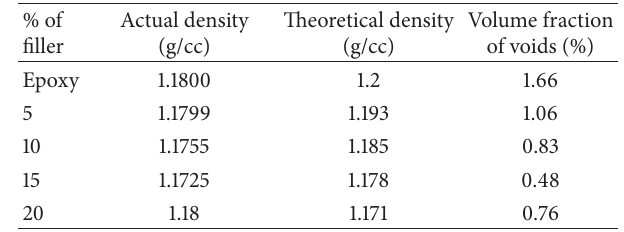
Table 4: Density and void contain of wood apple